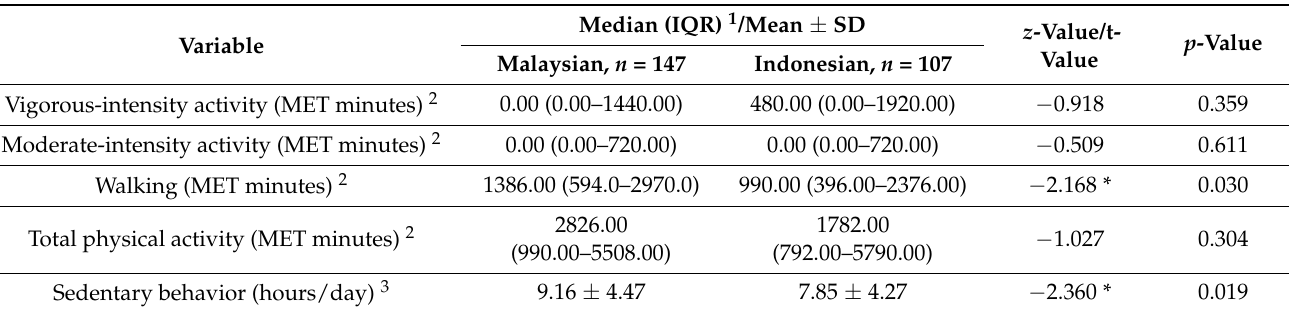
Table 2. Time devoted to physical activity and sedentary behavior among university students.